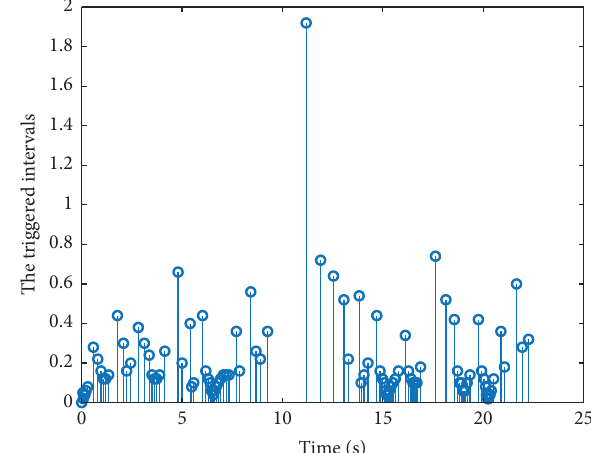
Figure 7: Te triggering instants for METP.